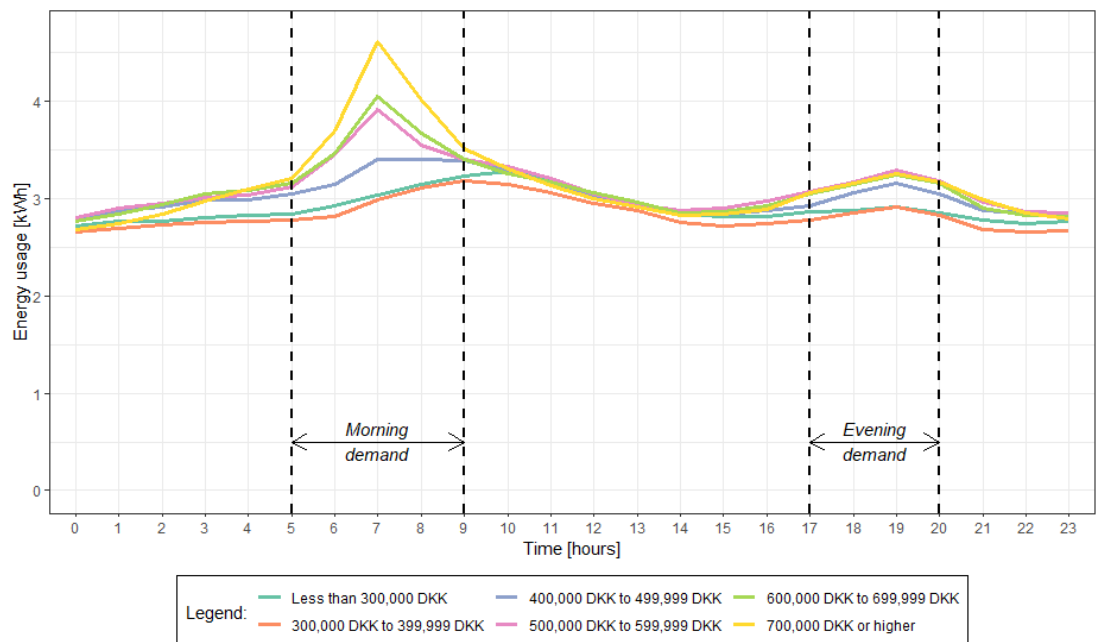
Figure 7. Heat usage profile for an average day for groups comparing income groups based on total annual household disposable income based on average hourly consumption. N = 2,005,091; n = 803.